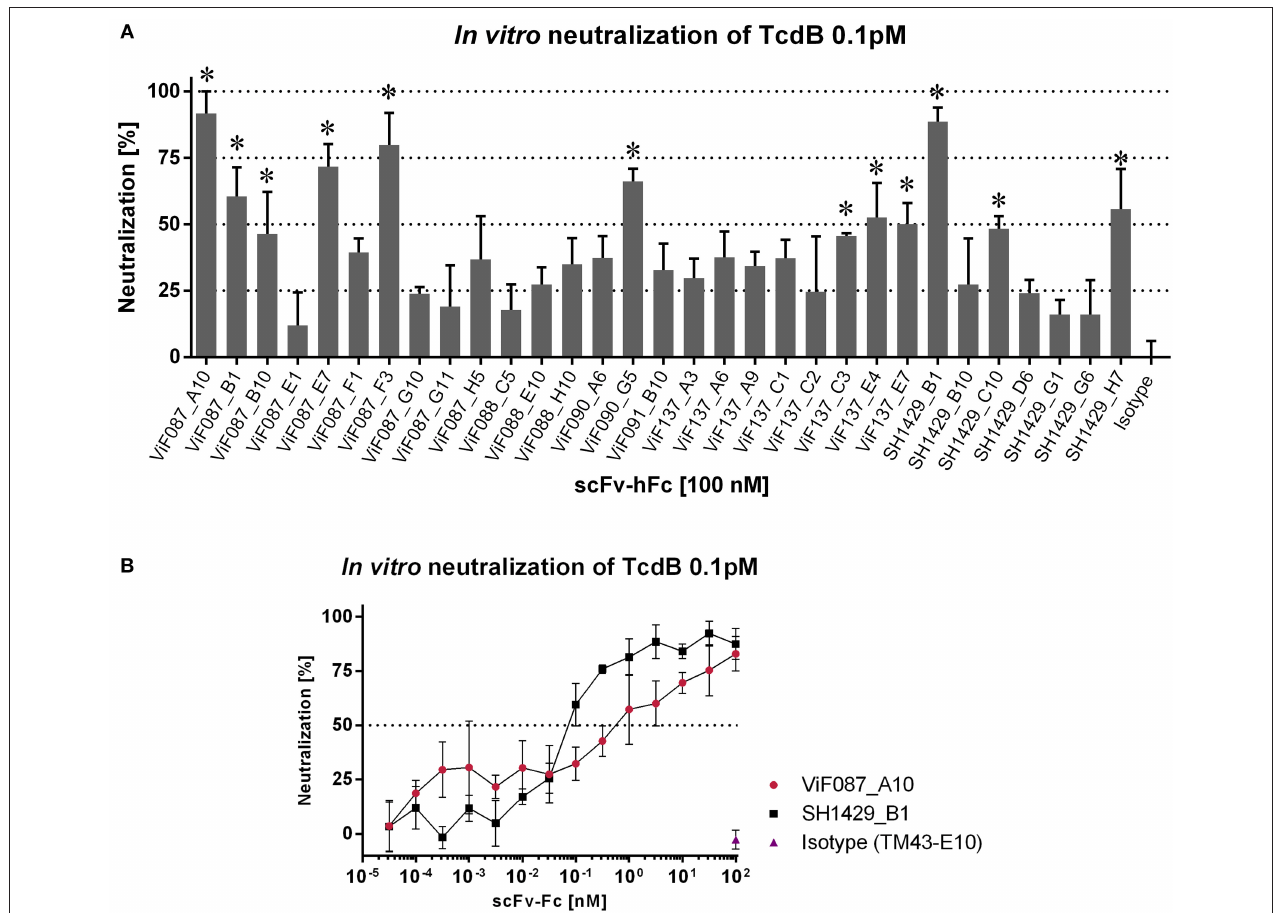
FIGURE 3 | In vitro neutralization of TcdB. TcdB (0.1 pM) and mAbs were coincubated in cultivation media and transferred to subconfluent Vero cells in 96 well plates. Pictures of each well were taken when cell rounding in NK control wells (TcdB w/o antibody) was 70–80%. Number of round cells were normalized to NK control and percentage of round cells after media exchange (w/o toxin or antibody) was set to 100% neutralization. (A) Initial screening for neutralization using all 31 mAbs in a 10,000-fold molar excess. Bars represent technical triplicates with SD as error bars. A one-way ANOVA test was performed for each antibody against the